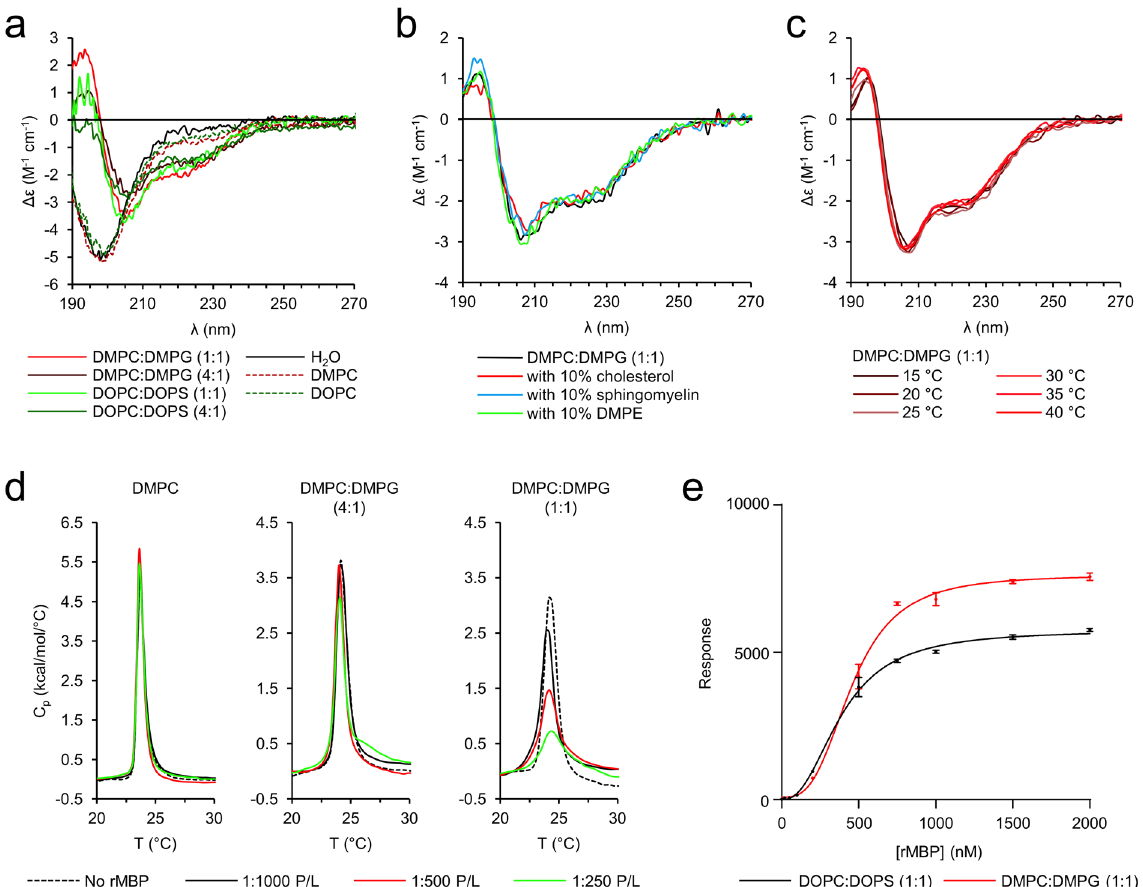
Figure 2. Lipid interactions of rMBP. ( a ) rMBP gains secondary structure in the presence of liposomes with increasing net negative surface charge, whereas it remains unfolded with net neutral lipids. ( b ) Cholesterol, sphingomyelin, or DMPE do not alter the secondary structure content of rMBP in net negatively charged DMPC:DMPG (1:1) vesicles. ( c ) Scanning around the lipid tail phase transition temperature does not affect the folding of MBP (right). ( d ) rMBP changes the lipid tail endothermic phase transition behaviour only when the MLV surface charge is net negative. ( e ) The association of rMBP with immobilised lipid vesicles probed using SPR. Error bars represent standard